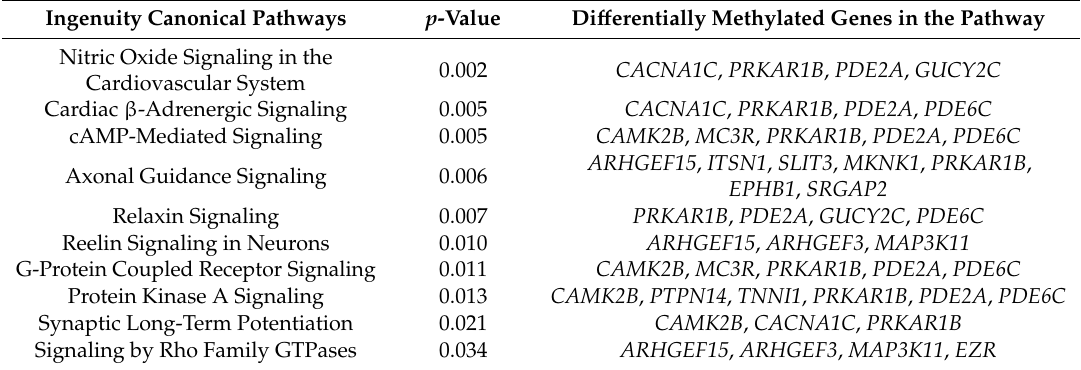
Table 2. Top 10 canonical pathways implicated by DMRs in the P15 iron-deficient rat